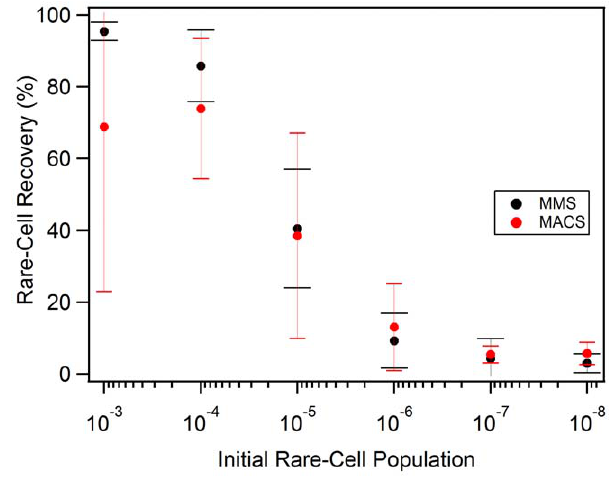
Rare-cell and ultra-rare cell recovery results for the MMS (black) and manual MACS (red) comparison. In four independent trials, both the MMS and MACS show cell recovery down to 10 2 8 , with the MMS having greater between experiment cell recovery performance through all of the populations tested, given the smaller RMSD reported as error bars for each sample.